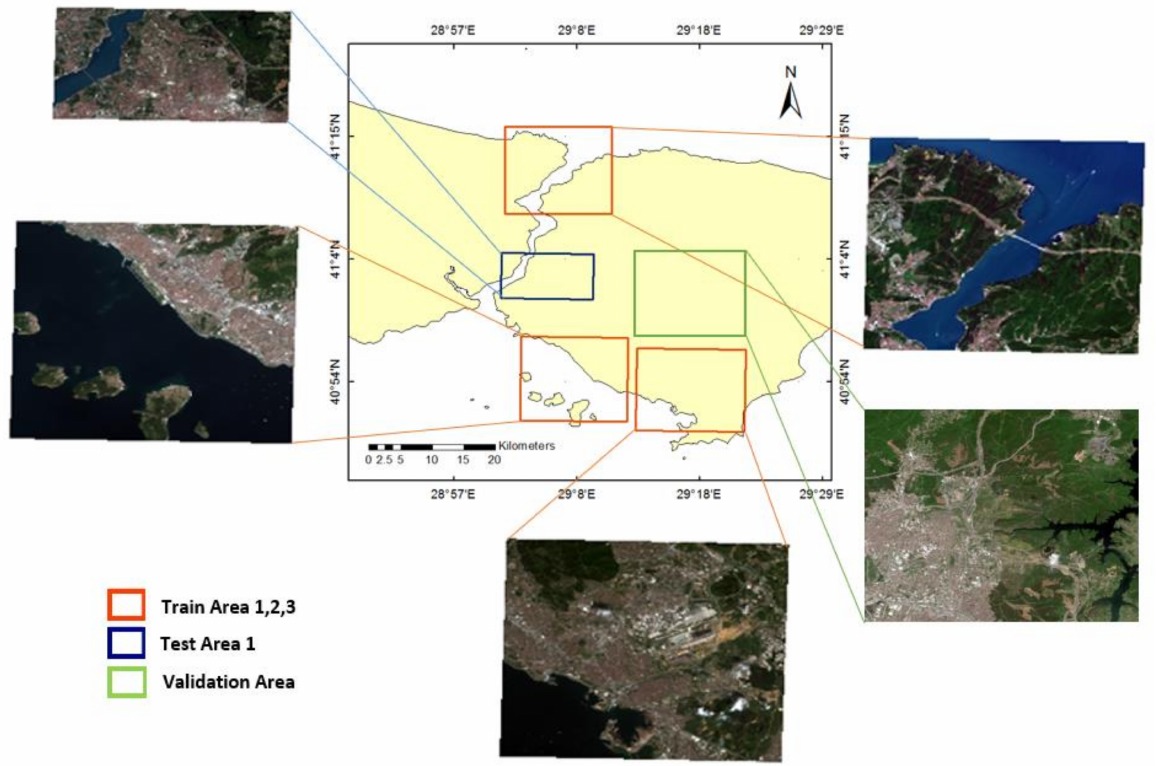
Figure 2. Subset images of Sentinel-2A in Istanbul city for the